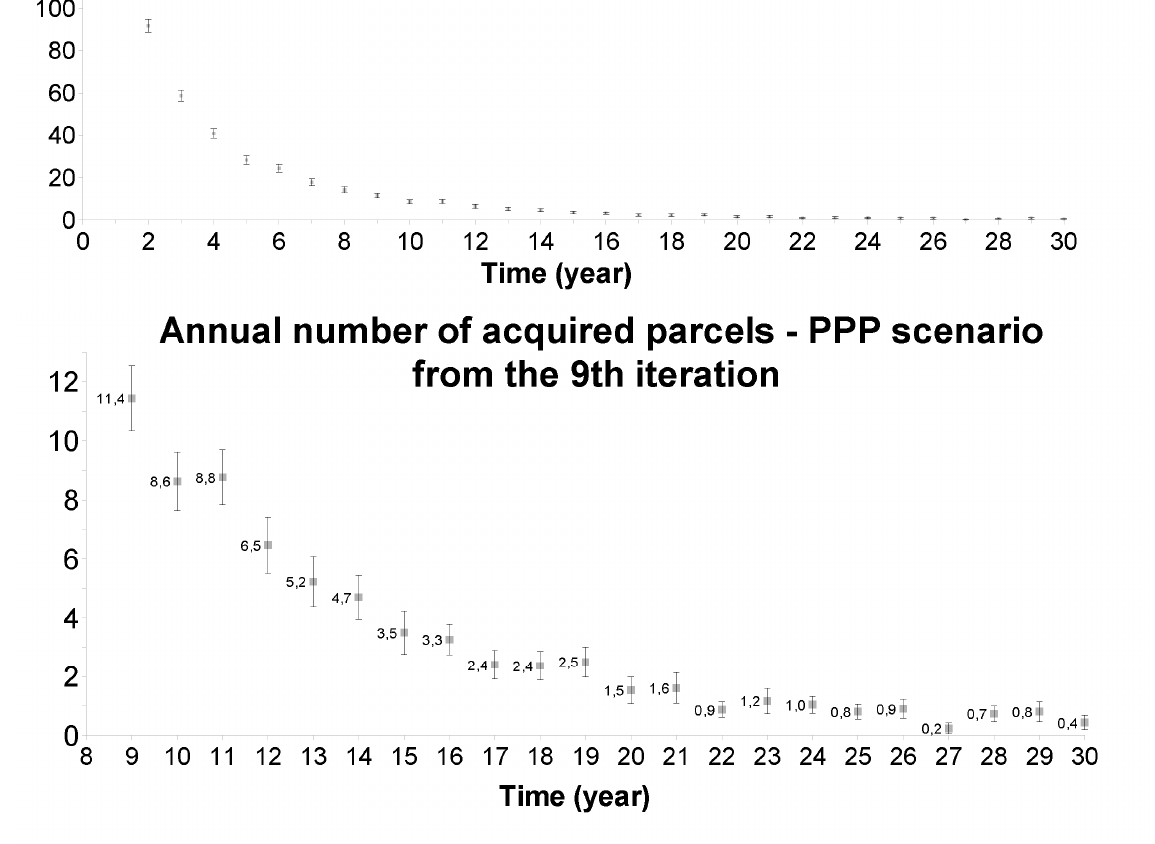
Figure 7. Annual number of acquired parcels and its confidence interval simulated over a 30-year period for the scenarios BAU and PPP (the sub-graph at the bottom shows the annual number of plots acquired from the ninth iteration for the PPP